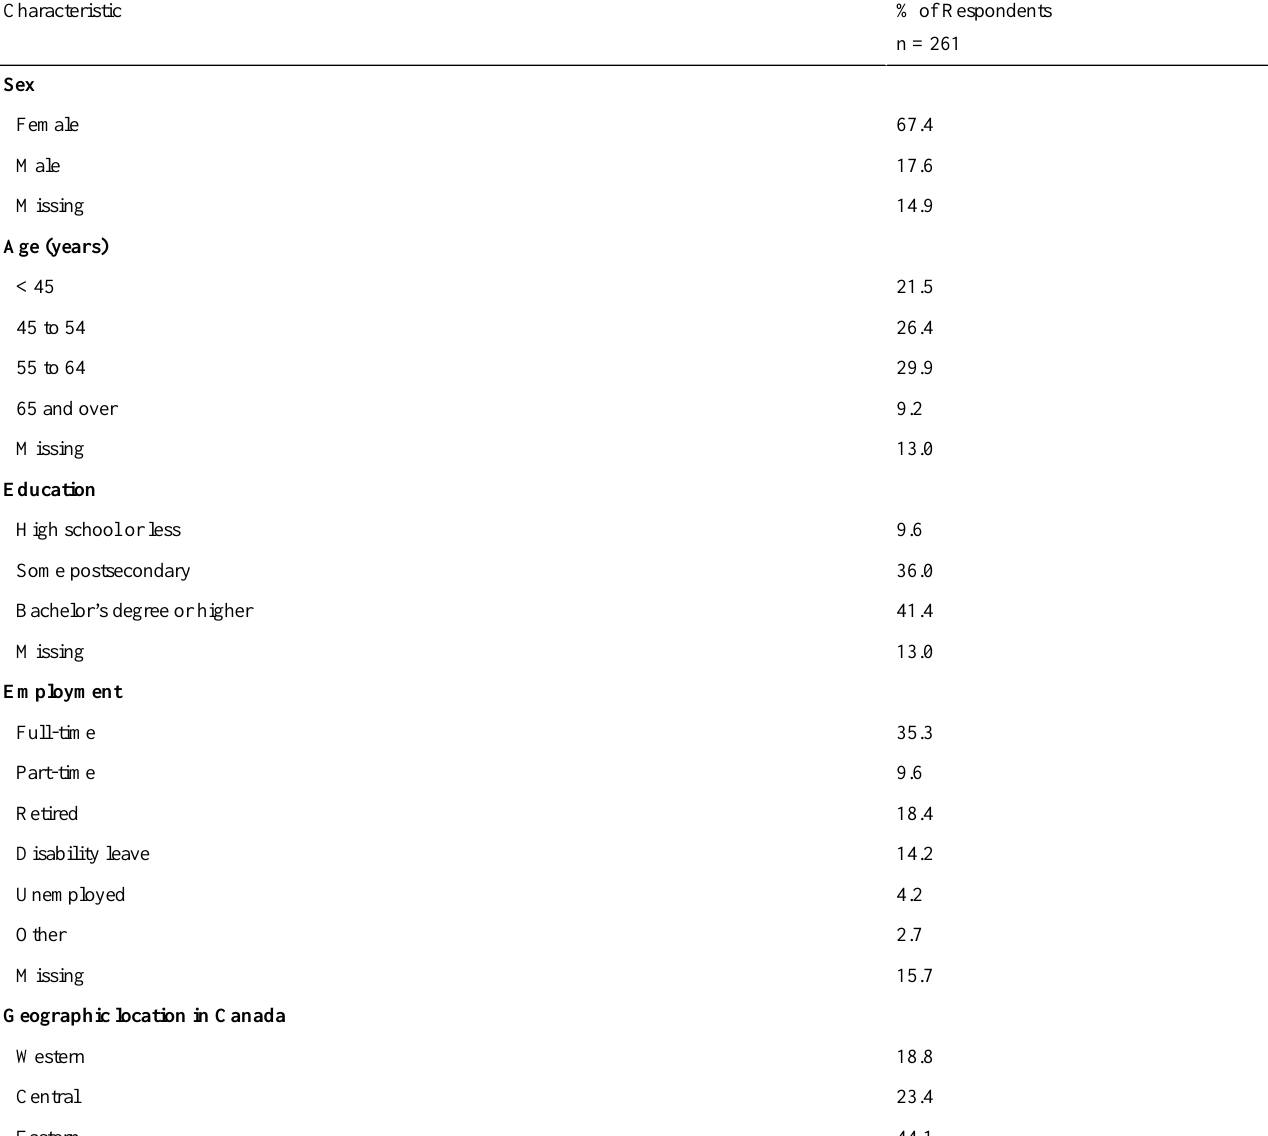
% of Respondents n =